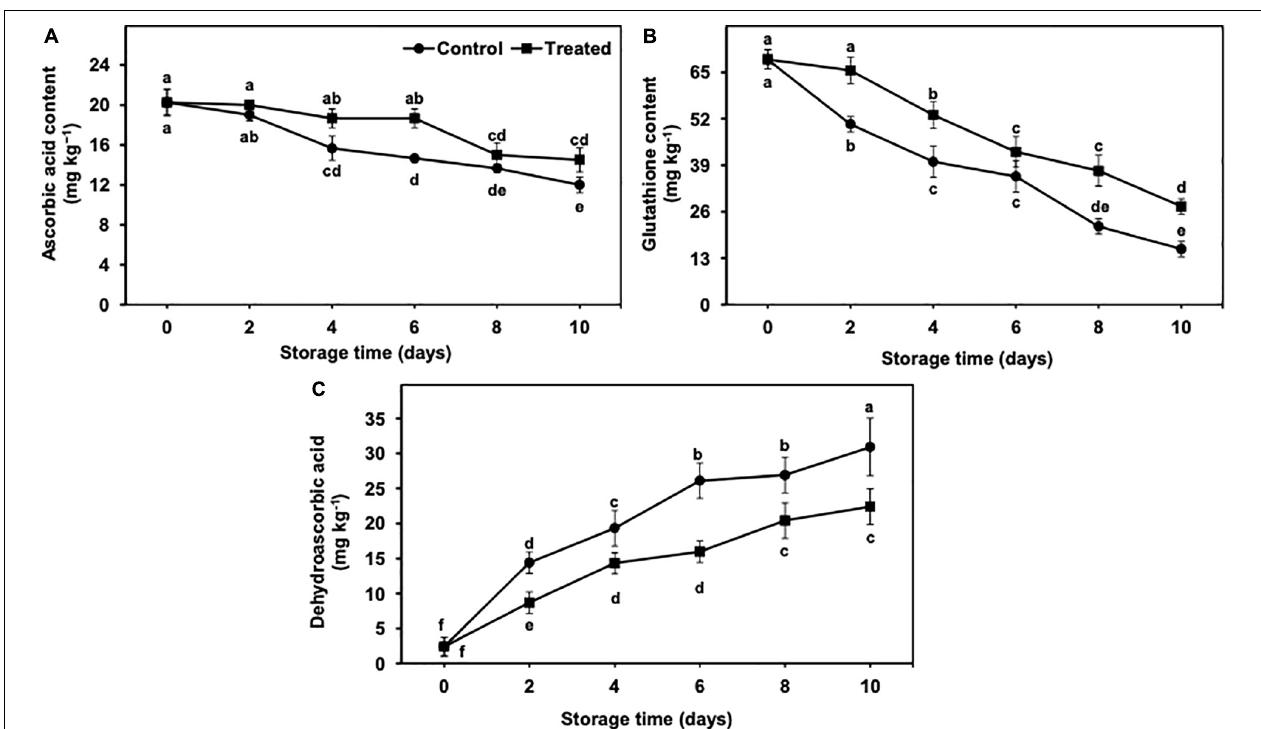
FIGURE 9 | Effect of hydrogen sulfide on ascorbic acid (A) , glutathione (B) and dehydroascorbic acid (C) contents in peel of banana fruit. Data are mean of three replications and vertical bars show standard of the means. Different letters show significant difference according to least significant difference